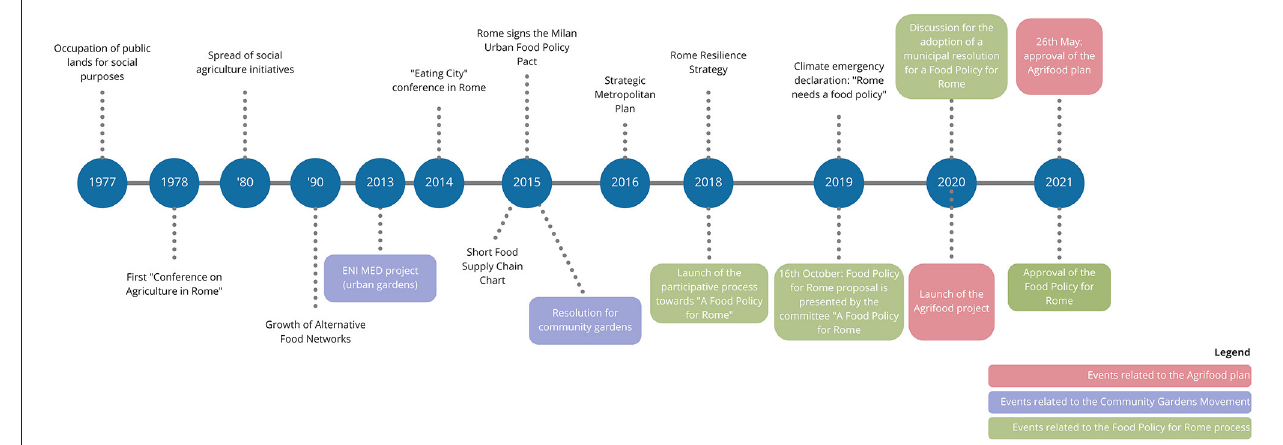
FIGURE 2 | Timeline of Rome food policy processes (source: authors).